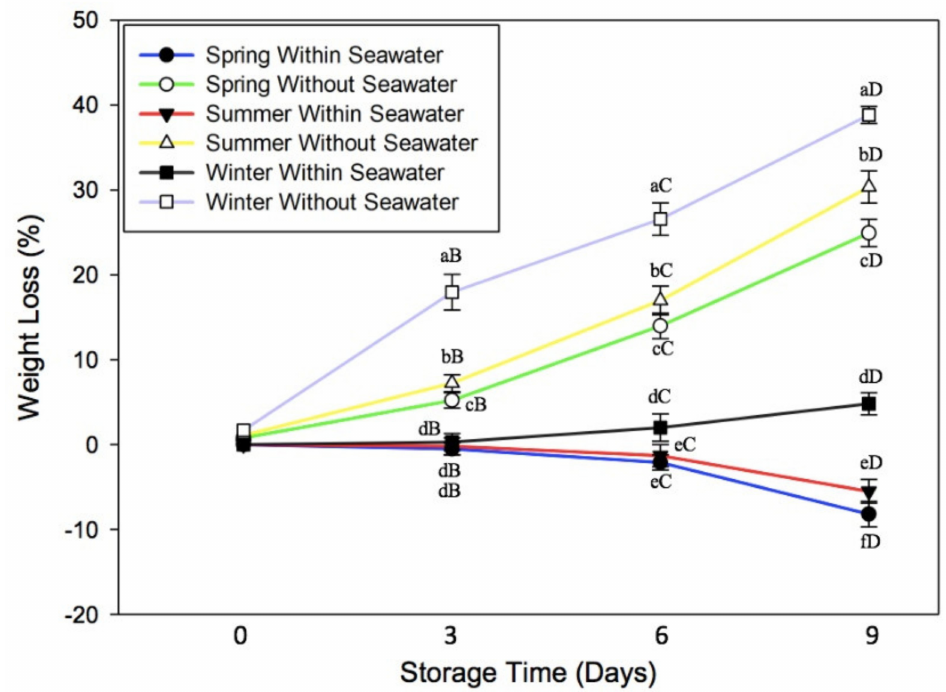
Figure 2. Oxidative stress effect on water content of seagrape in different seasons during post-harvest storage. The data express means ( n = 3) with the error bar shows standard deviation. a–f Means express the significant differences in the same storage time ( p < 0.05). B–D Means express the significant differences in the same treatment ( p <